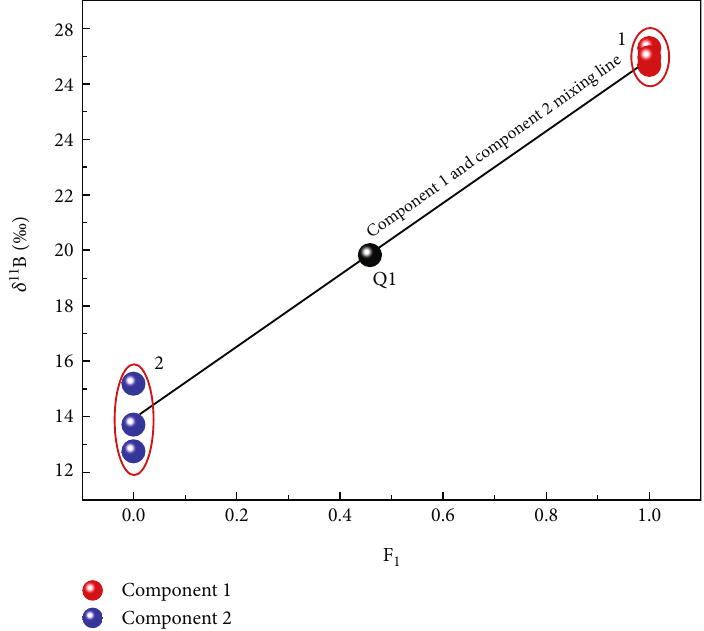
Figure 10: Mixing relationship between component 1, component 2, and Q1.